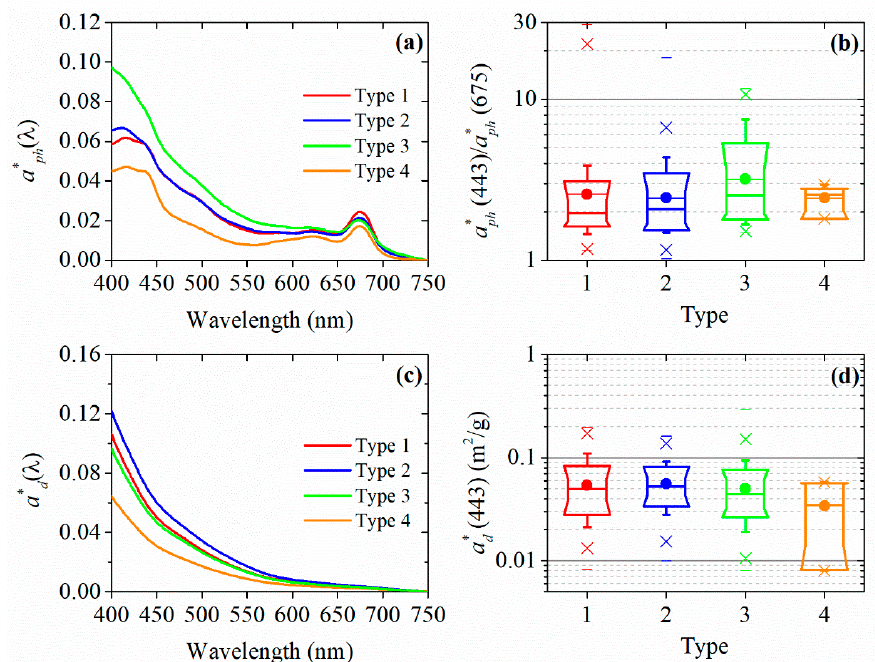
Figure 6. ( a ) Mean spectra of the absorption coefficient of phytoplankton normalized to the Chl a concentration ( a * ph ( λ )) of types 1–4. ( b ) Boxplots of a * ph (443)/ a * ph (675) for each OWT in the field-measured data. ( c ) Mean spectra of the absorption coefficient of NAP normalized to the SPM concentration ( a * d ( λ )) of types 1–4. ( d ) Boxplots of a * d (443) for each OWT in the field-measured data. The sample median is indicated by a line within the box, the dots represent the mean value, and “x” represents data beyond the bounds of the error bars.